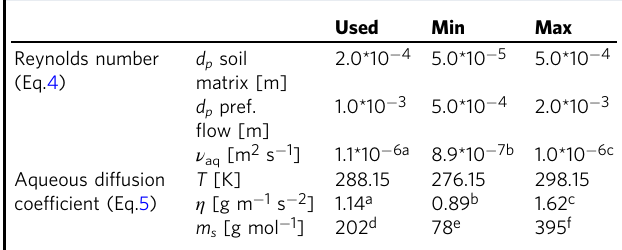
Table 1 Parameter range for the calculation of D w and Re in soil. Given are the variability of the grain diameter d p the kinematic viscosity of water ν aq , temperature T , dynamic viscosity of water η , and the molecular weight of the diffusing contaminant m s